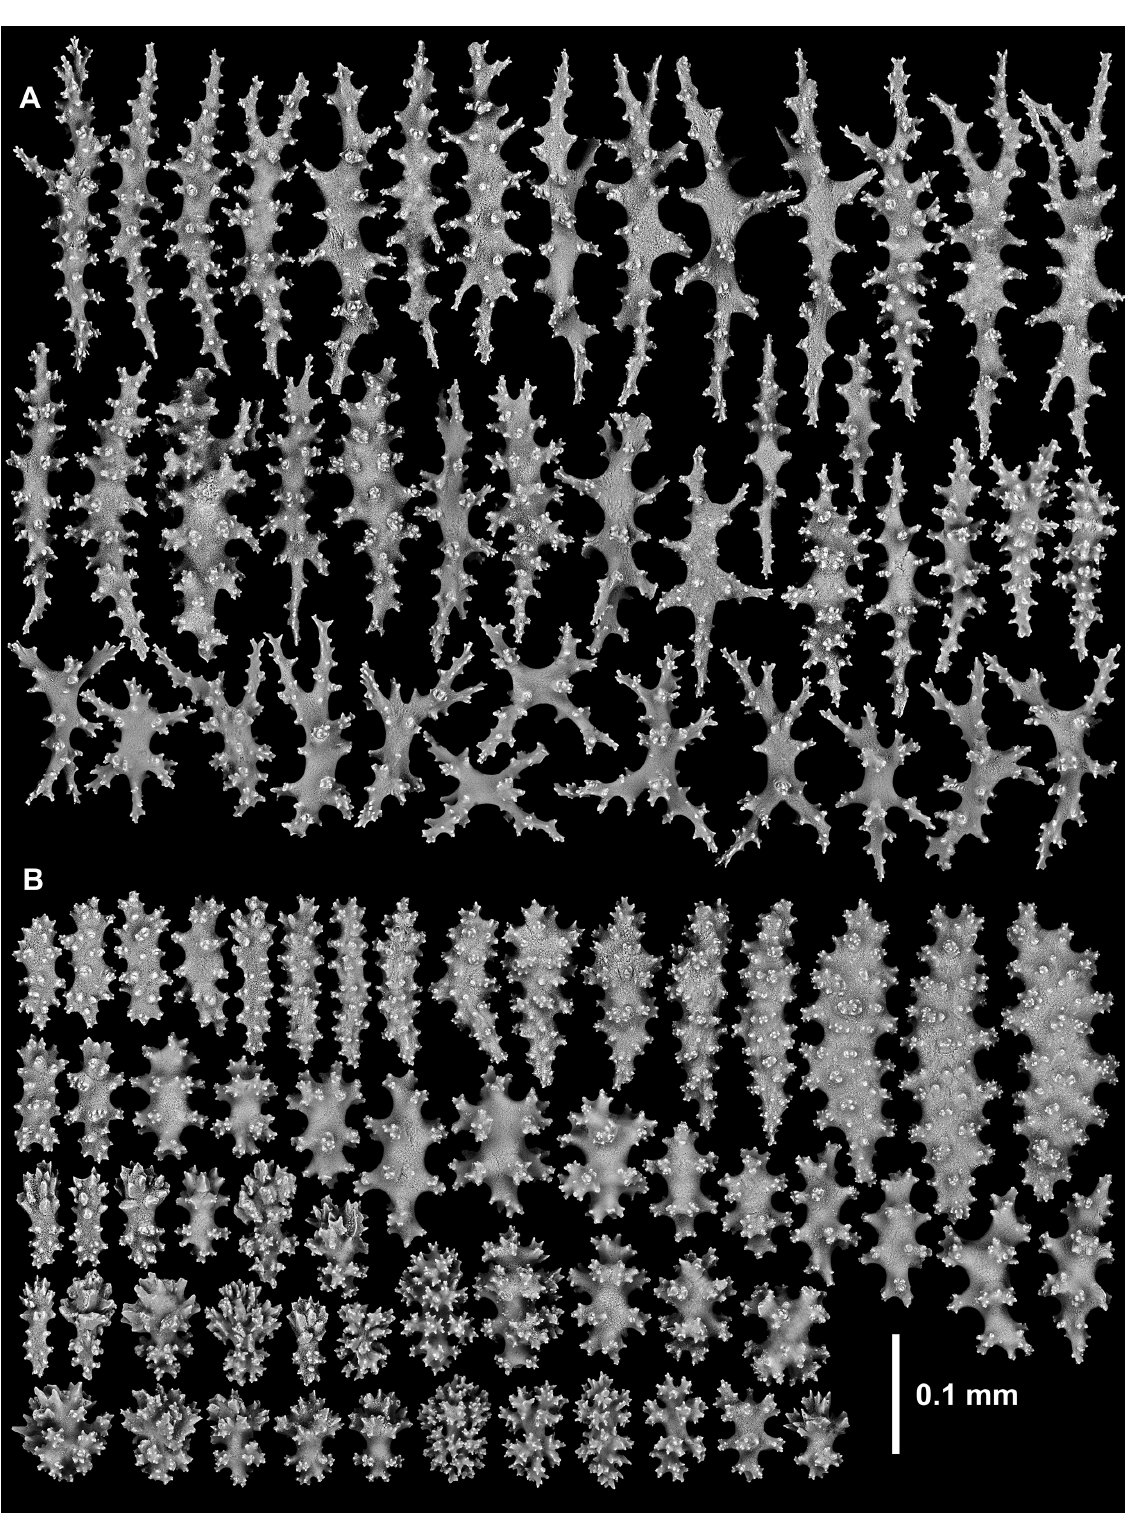
Fig. 20. Kotatea lobata gen. et sp. nov., holotype (NIWA 101313), SEMs of sclerites. A . Lobe interior. B . Base